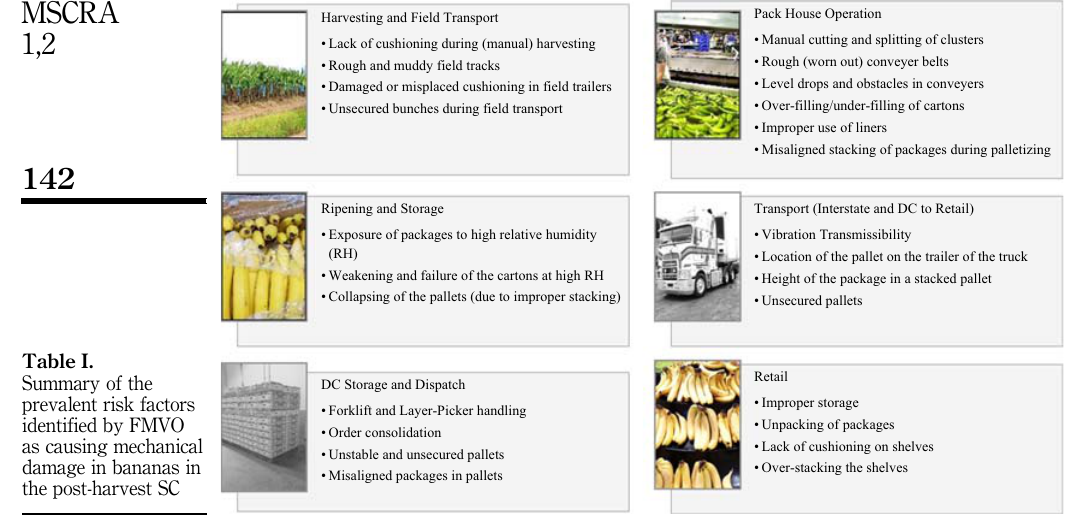
Table I. Summary of the prevalent risk factors identified by FMVO as causing mechanical damage in bananas in the post-harvest